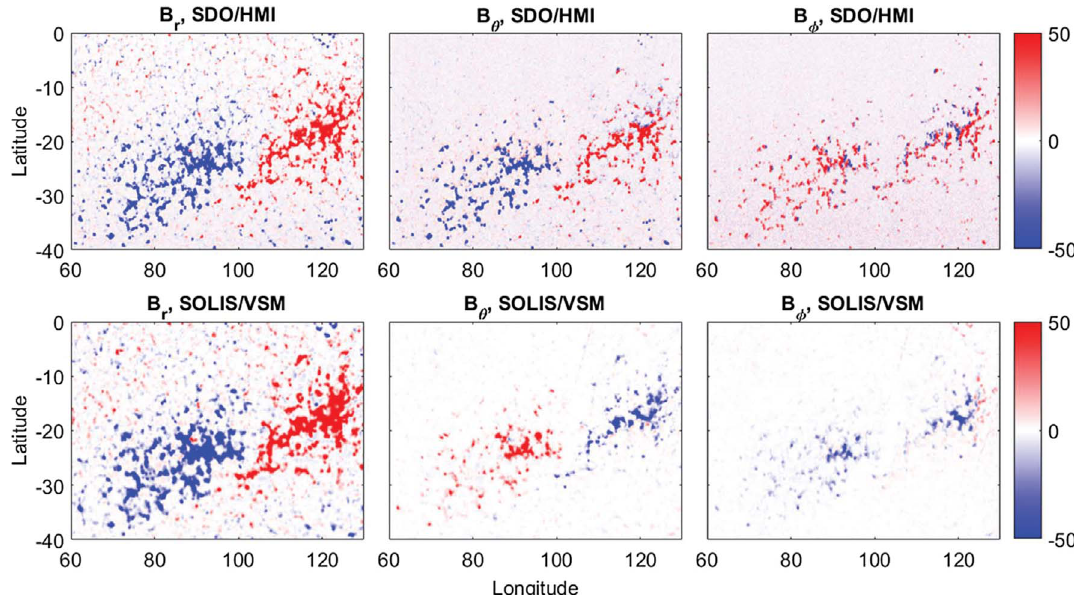
Fig. 1. Example of disagreement in orientation of B h and B u Magnetic fi eld vector components of an active region in the southern hemisphere, which passed the central meridian on 19 November 2015. Upper panels show radial ( B r ), meridional ( B h ) and zonal ( B u ) fi eld from SDO/HMI and lower panels from SOLIS/VSM. Meridional (middle) and zonal (right) components depict opposite orientation. Red/blue represent positive/ negative polarities scaled between ±50 G (see color bars on the right side of fi